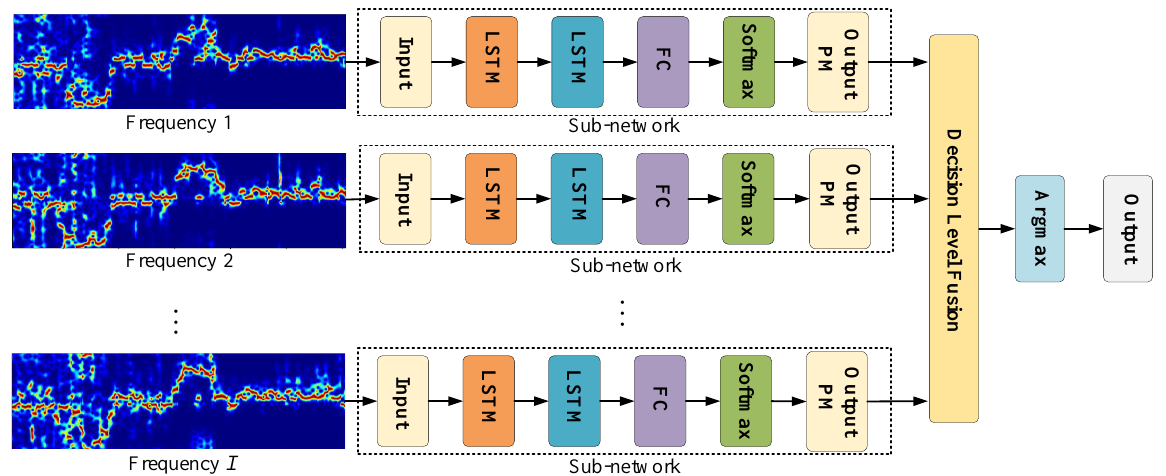
Figure 7. Diagram of parallel LSTM